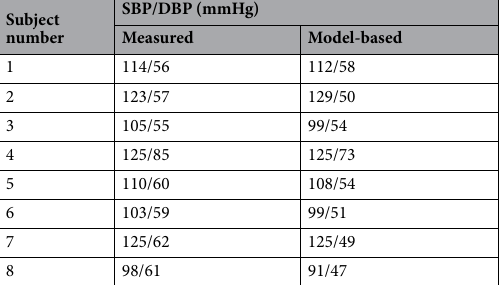
Table 2. Comparison of measured and model-based SBP and DBP values for the eight subjects in the study. Measurements of SBP and DBP were obtained non-invasively in the brachial artery. The model-based SBP and DBP correspond to the maximum and minimum of the model-based aortic pressure waveform,